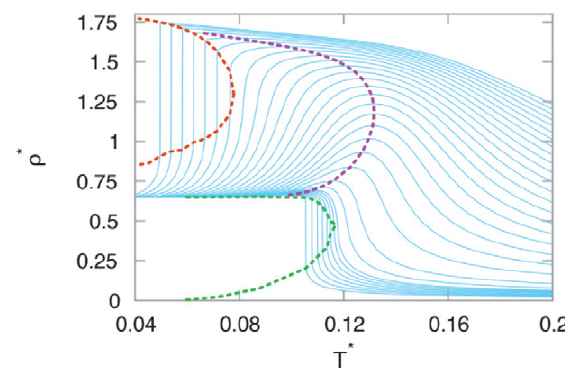
Figure 12: Temperature dependence of the density for various pres- sures (blue solid lines), high-density liquid–low-density liquid co- existence line (red dashed line), liquid-gas density coexistence line (green dashed line), and maximum densities (pink dashed line).